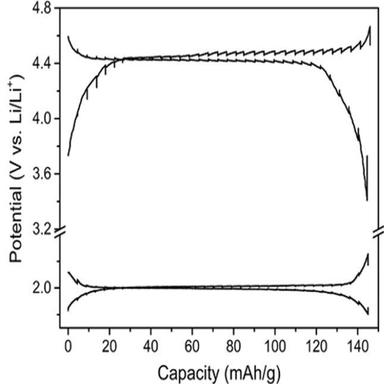
GITT characterisation was conducted on LiVPO4F electrodes against an Ag/AgCl reference for both anode and cathode at a 2C rate. Potentials were converted to the Li+/Li reference scale. Specific capacities were calculated based on the mass of the active material. Reproduced with permission from Wiley.